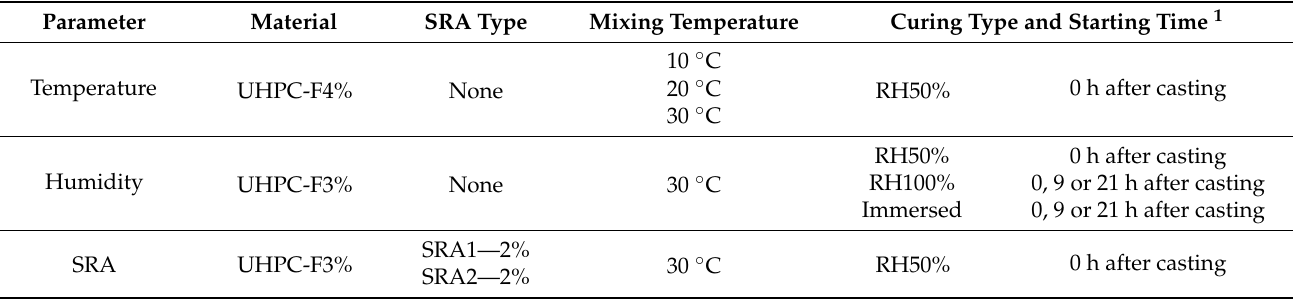
Table 1. Experimental